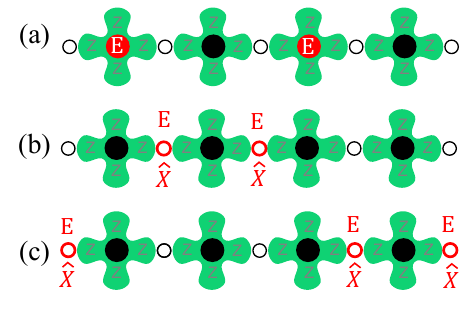
Figure 23: (a) Two measure-Z qubits report errors ( E ) in a row of a 2D array. This could be generated by (b) two X errors appearing in one surface code cycle, or (c) three X errors appearing in the other three data qubits. Figure from Ref. (Fowler, Mariantoni, Martinis and Cleland,